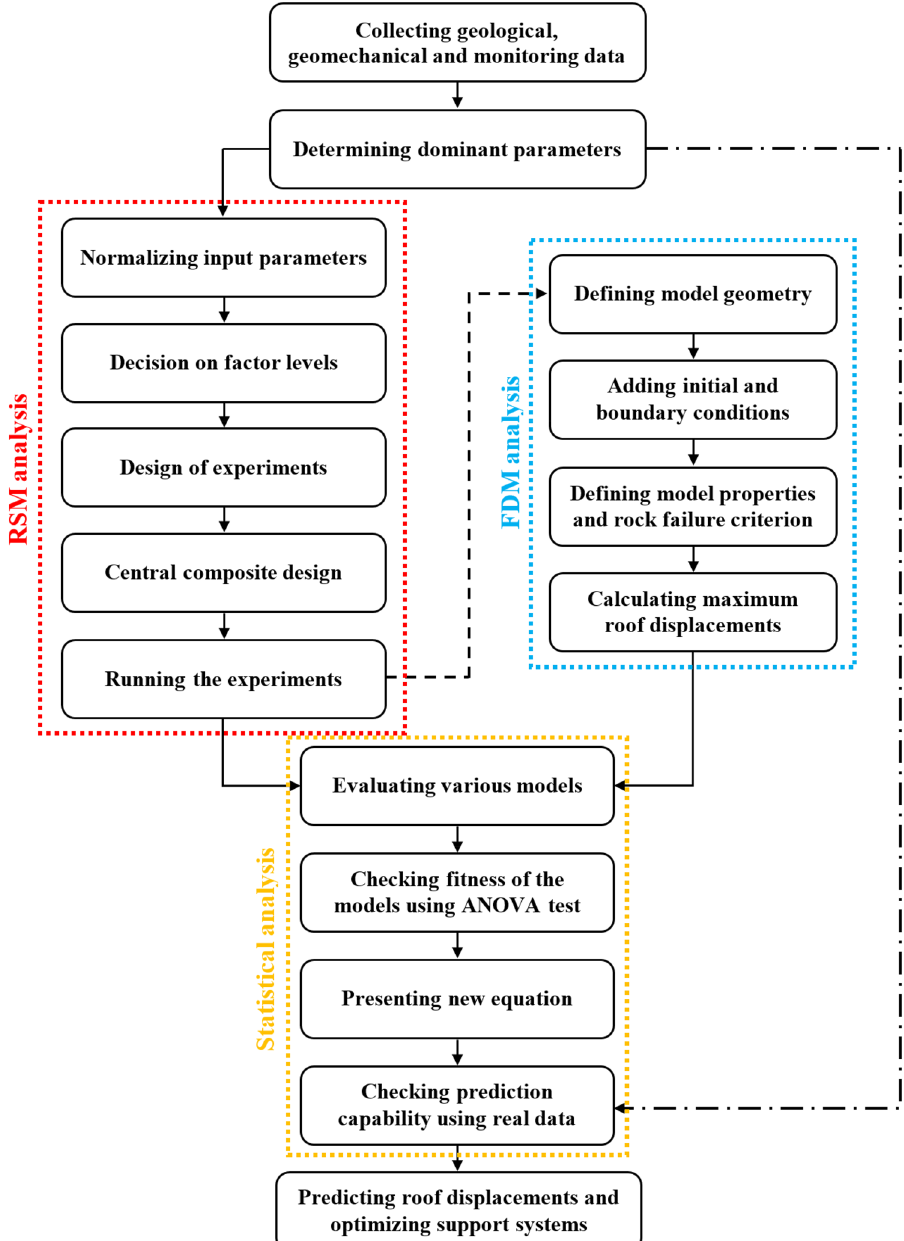
Figure 5. Steps of the proposed model for optimization of support systems in longwall